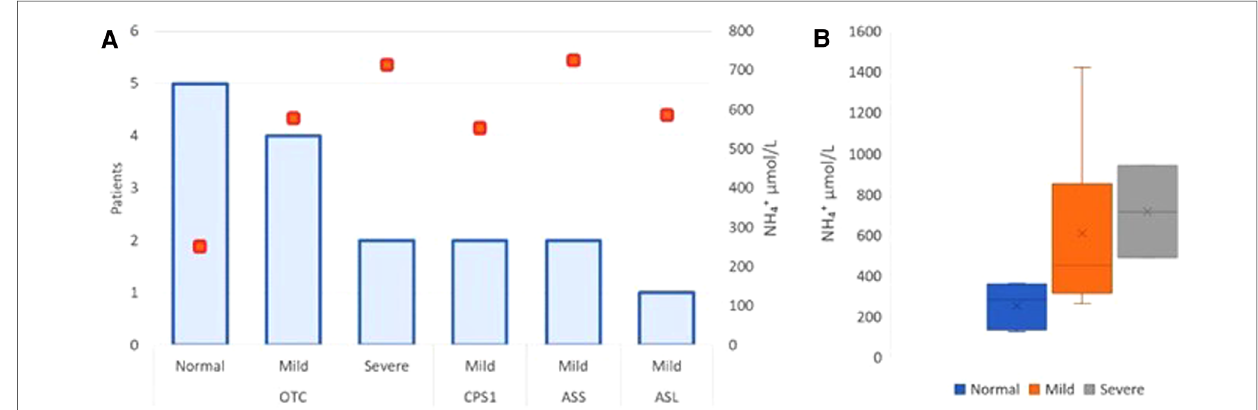
FIGURE 3 Neurodevelopmental outcomes — correlation with mean ammonium level and UCD type. Severe neurological impairment was considered in those patients diagnosed with epilepsy and cerebral palsy categorized with Gross Motor Function Classi fi cation System (GMFCS) level 5. Mild neurological impairment was described in those with motor, speech or global delay. Normal neurodevelopment included normal motor and intellectual status. The correlation with UCD type, neurological outcome, and mean ammonium level at diagnosis showed that the maximum ammonium level at onset was higher (>500 µmol/L) in those with neurological damage including mild and severe. Orange boxes show the peak of ammonium level in neurological outcome related with the UCD type. ( A ) Schematic box plots for neurological outcome show the distribution of the ammonium values within each group. The x mark shows mean on each category with its respective range: Normal 251,6 (123 – 361); Mild 606 (312 – 1420); Severe